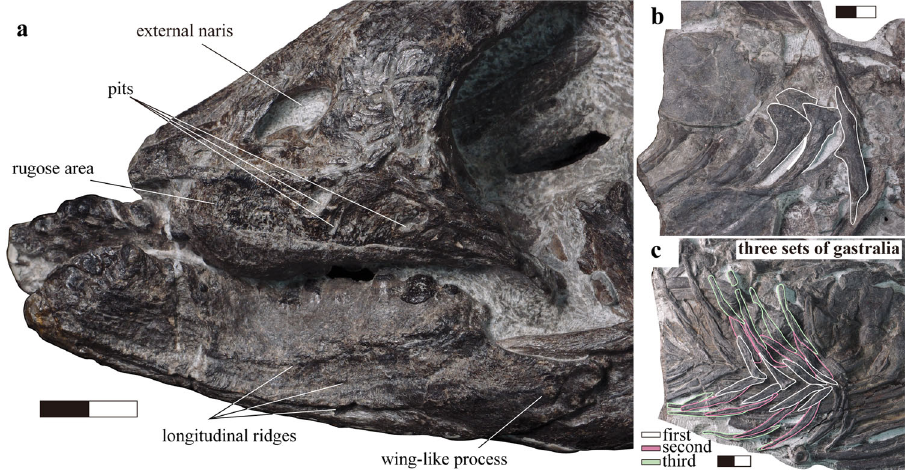
Fig. 4 Details of the skeleton of Sclerocormus cf. S. parviceps (HFUT MJS-16-012). a Photo showing the surface ornamentation of the premaxilla, maxilla and dentary. b Photo showing the single-headed ribs and the interclavicle with a short posterior process. c Robust gastralia with three pairs of segments. Scale bars equal 2 cm.